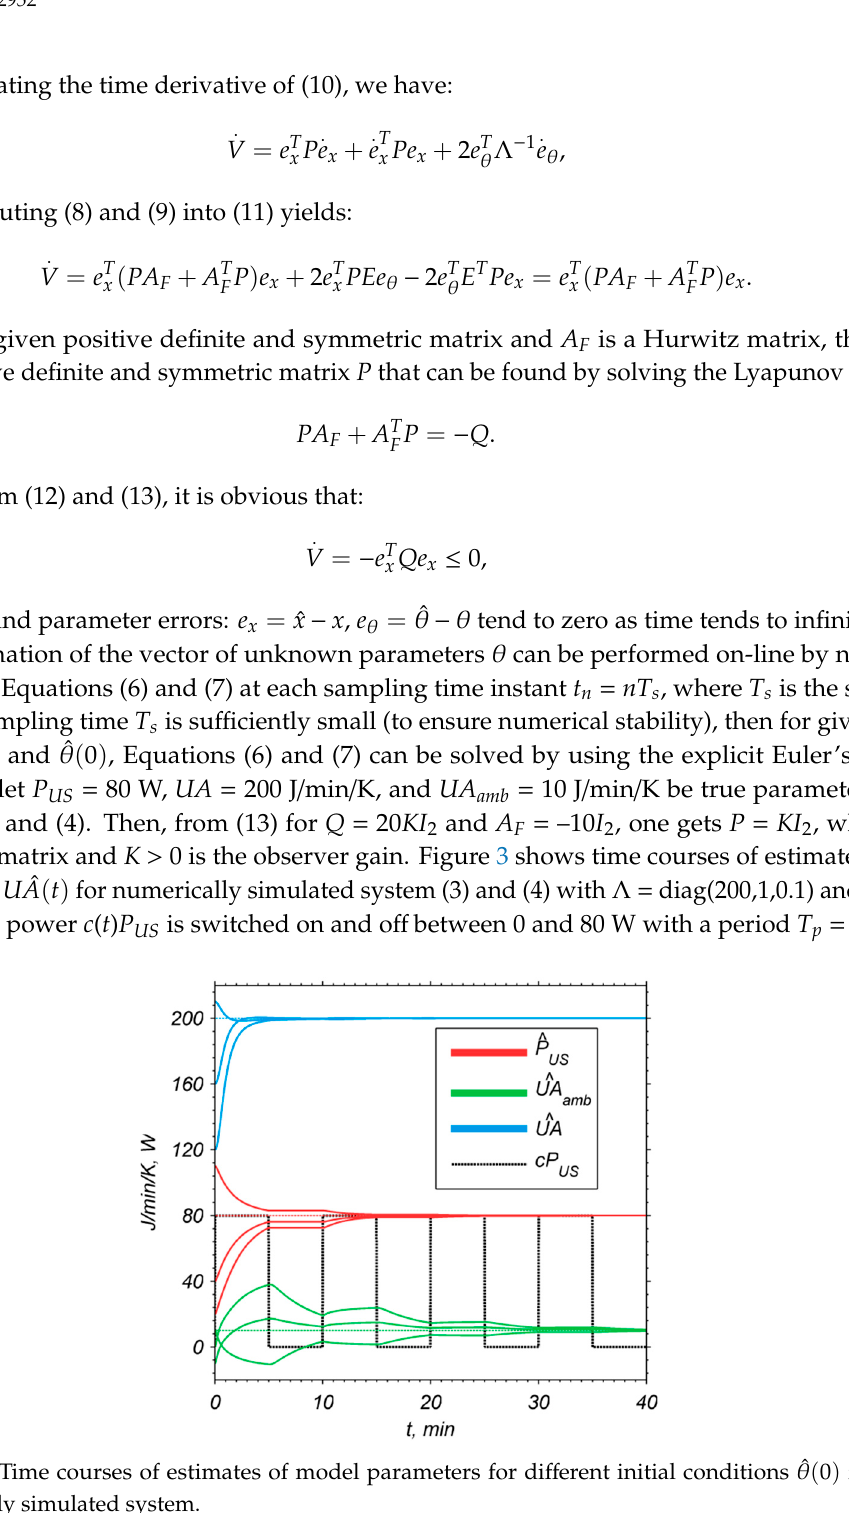
and ˆ(0) θ , the estimates converge to true values of 170